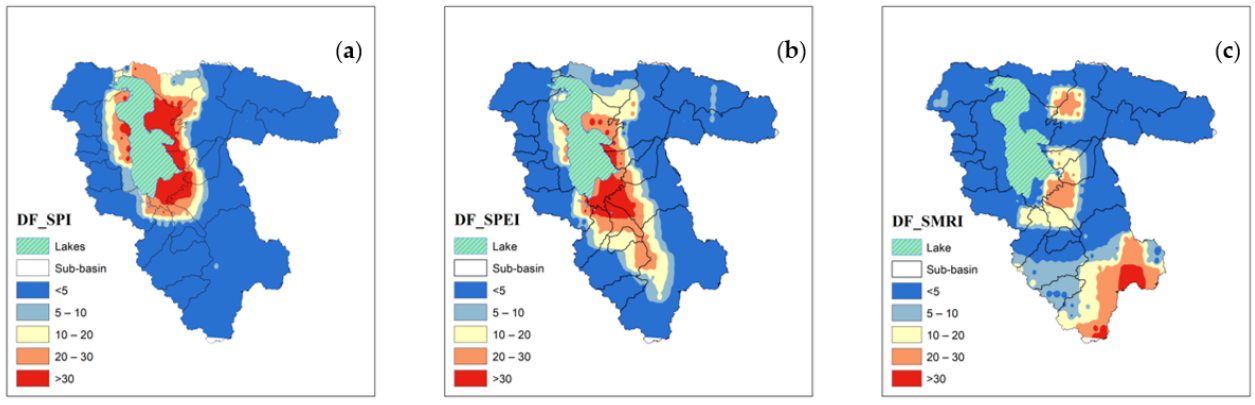
Figure 13. Drought Frequency (DF) maps over ULB basin during 1981–2018. ( a ) SPI_DF, ( b ) SPEI_DF, ( c ) SMRI_DF. Based on Table 2 threshold < − 1 considered as drought hot spots [91].